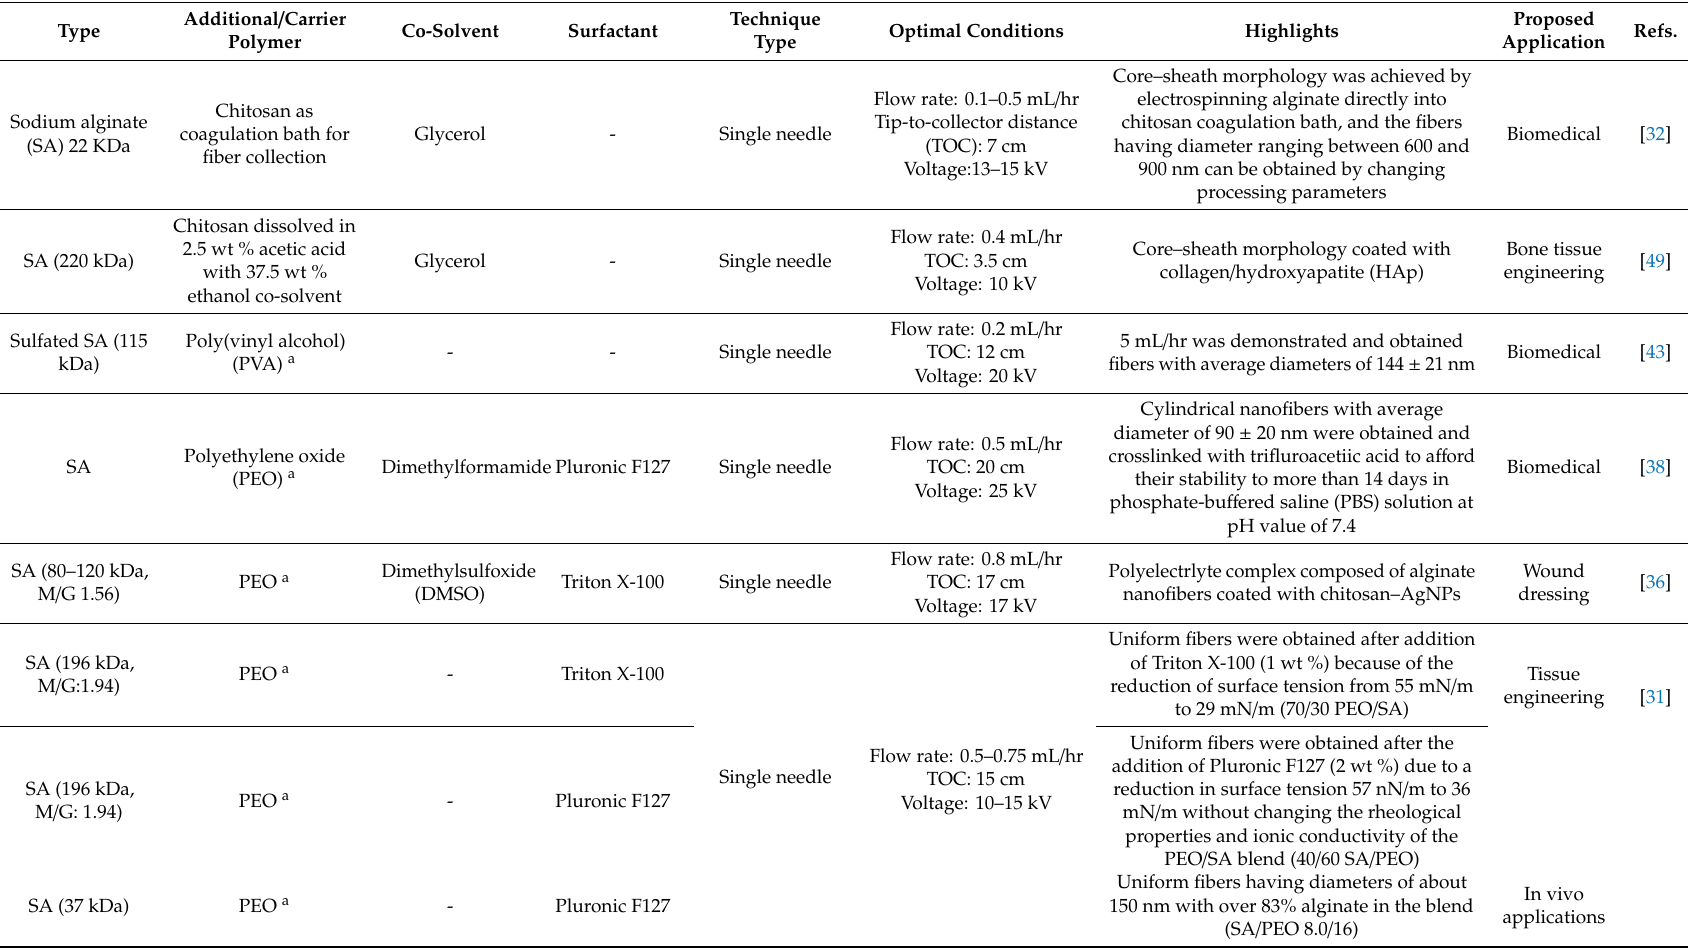
Table 1. Selected studies on the spinnability of